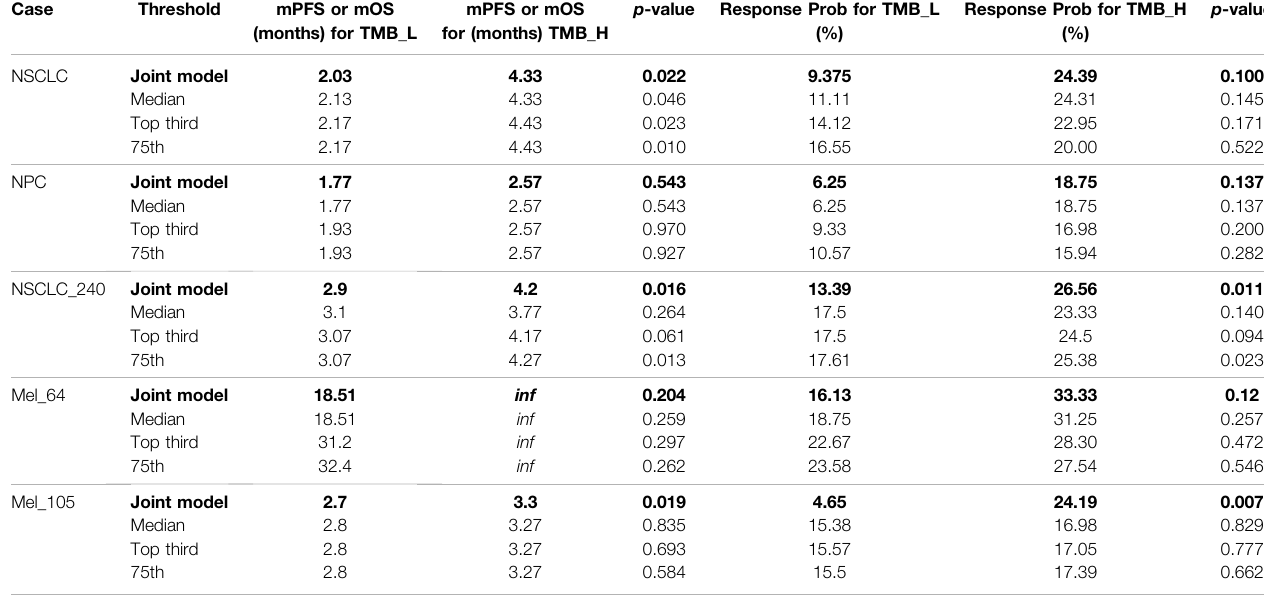
TABLE 7| Immunotherapy mPFS or mOS and responseprobability based on different tumor mutation burden (TMB) thresholdswithmeasurement errors for non-small-cell lung cancer (NSCLC), nasopharyngeal carcinoma (NPC), bladder, renal cell carcinoma (RCC), and melanoma. p values are reported by log-rank test and the two-sided Mann – Whitney U